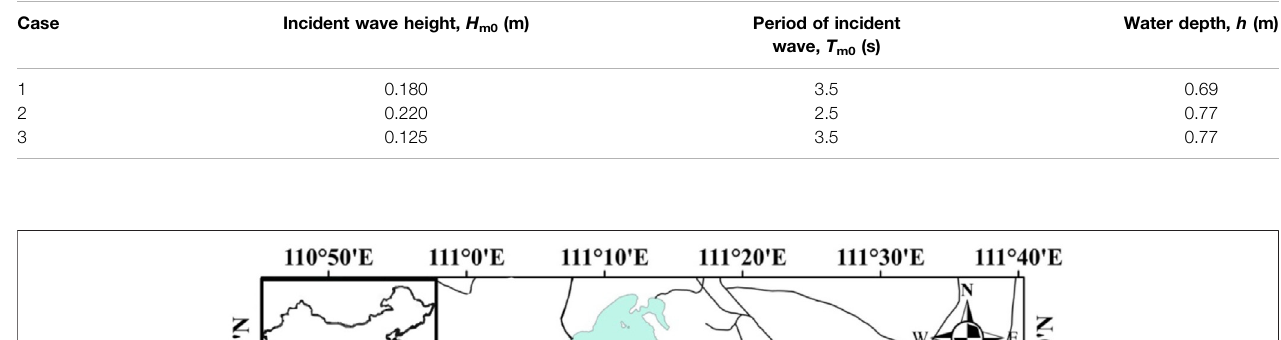
Frontiers in Environmental Science |